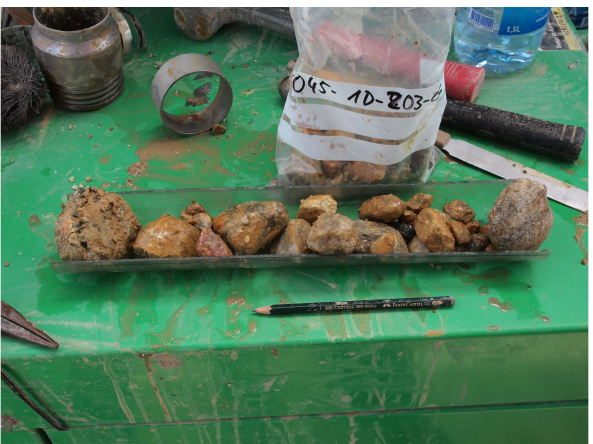
Figure 8. Rounded gravel and pebbles in core catcher material (DEEP site, hole 1D at 569mb.l.f.) indicate fluvial transportation.